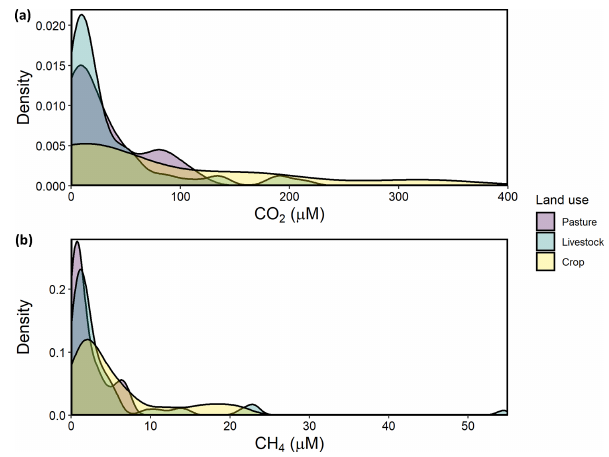
Figure 2. Kernel density estimates of CO 2 and CH 4 concentrations measured in 101 farm reservoirs grouped by land